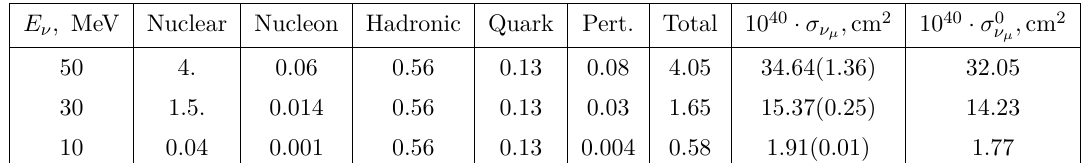
Table 2 . Contributions to the relative error (in % ) of the total CE ν µ NS cross section on 40 Ar target for an incident ν neutrino energy E . Cross section with radiative corrections σ µ ν the tree-level result σ 0 ν µ